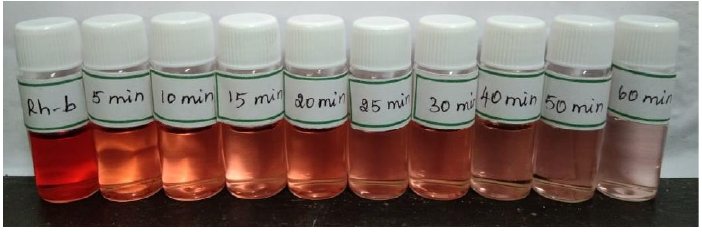
Fig.6 Rh-B dye Adsorption with synthesized C NPs:: Concentrations of the solutions Table 2. Percentage of degradation of Rh-B dye through adsorption and photocatalytic